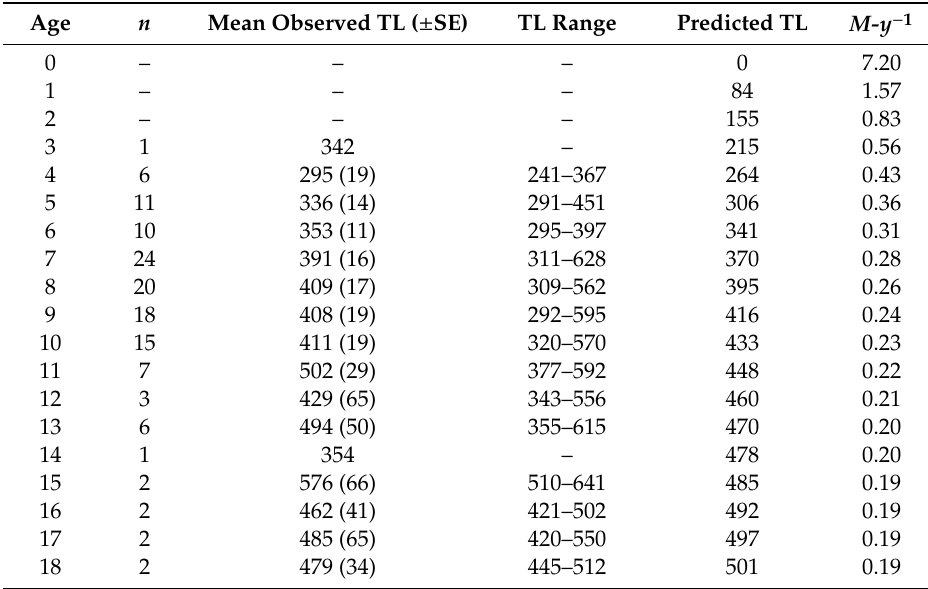
Table 2. Observed and predicted mean total length (TL) from the von Bertalanffy growth model, measured in millimeters, and natural mortality at calendar ‐ age [18] data for black margate ( Anisotremus surinamensis ) collected from 1979 to 2017 from the east coast of Florida. Standard errors of the means (SE) are provided in parentheses.